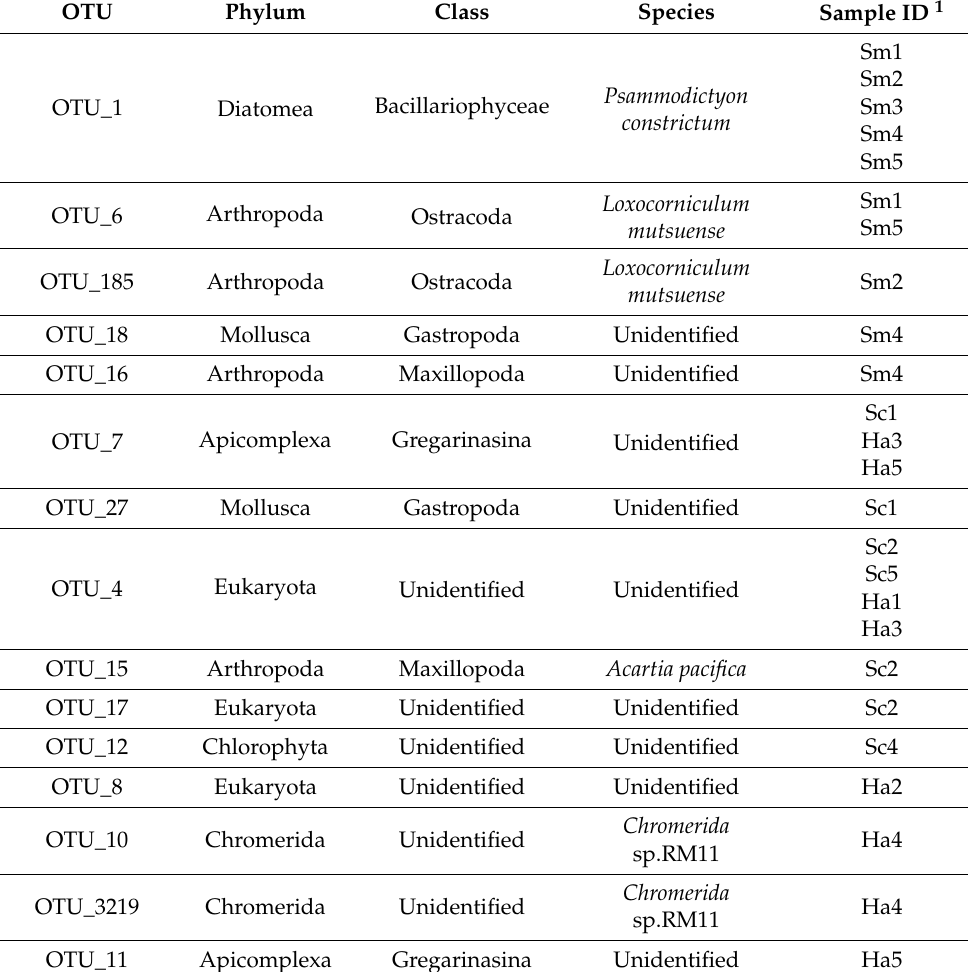
Table 1. OTUs whose abundance exceeded 10% in single gut